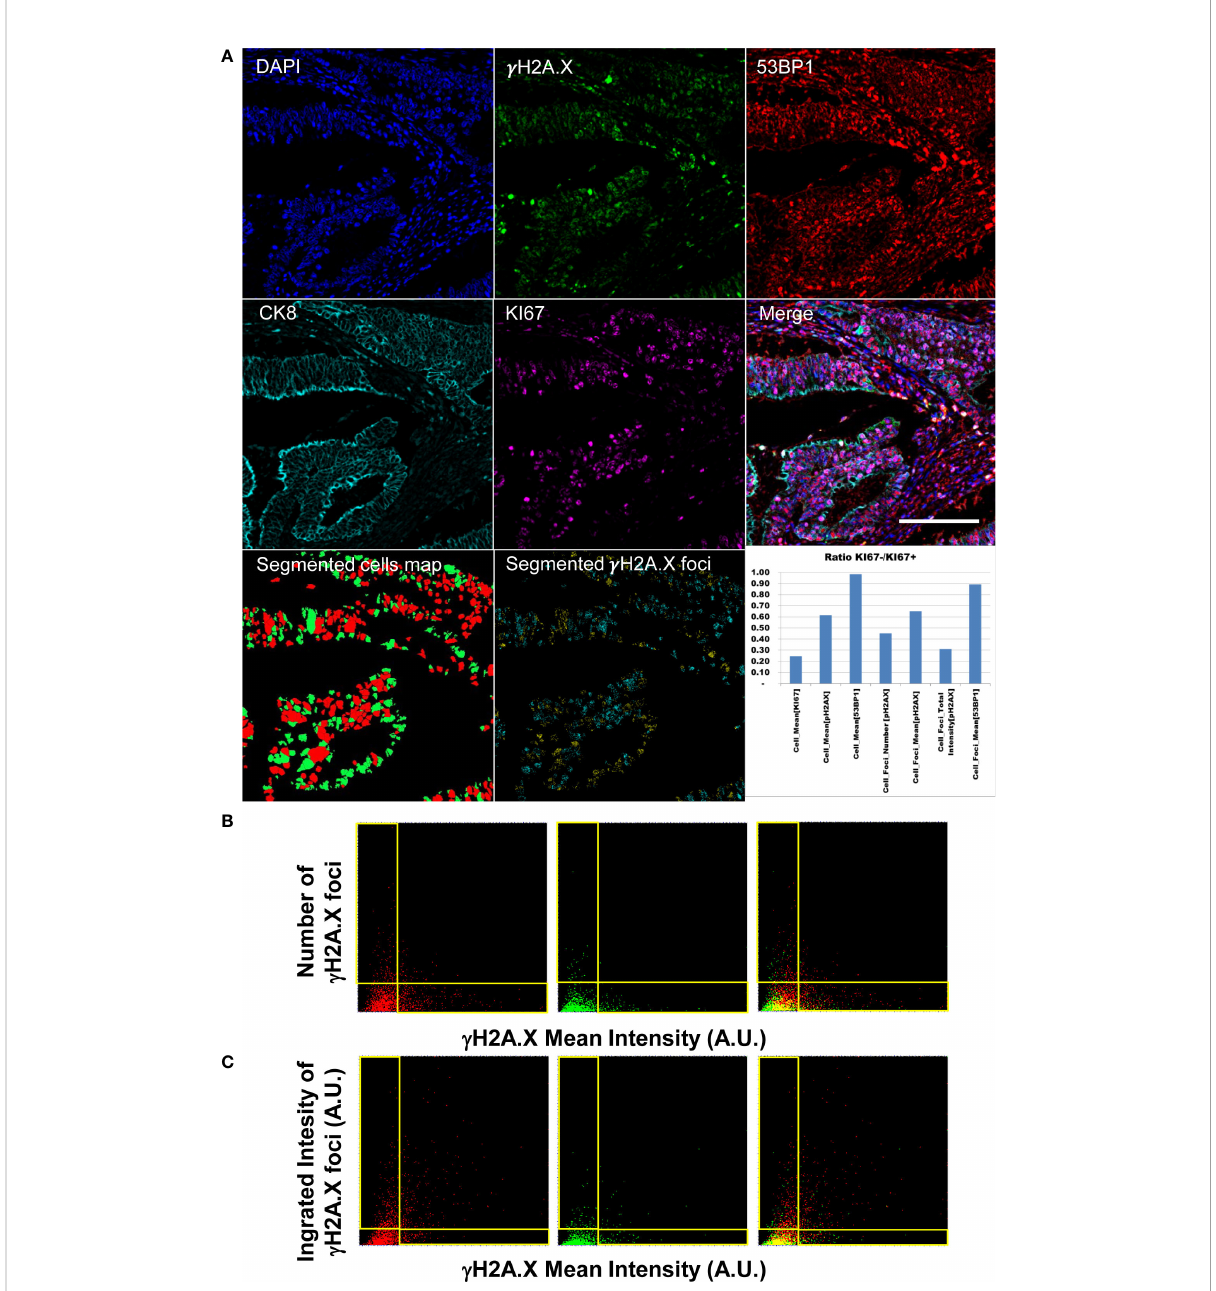
FIGURE 4 Diffraction-limited Image-Cytometry Analyis of a relocalized targeted core. Panel (A) : Images are collected with a 60x 1.4 Oil Immersion Objective to measure DDR related parameters at maximum spatial resolution and sensitivity on a selected region inside a previously acquired core: DAPI, g H2A.X, 53BP1, CK8 and KI67 (CK8 and KI67 rescaled to the same digital resolution from the previously acquired 20x acquisition employed to target the selected region; scale bar: 200 m m). Segmented masks of the cells (KI67+, Red; Ki67- Green) and of g H2A.X foci of the isolated cell populations (KI67+ Cyan spots; KI67- Yellow spots) are also reported. The graph shows the ratio of DDR related parameters values calculated for the quiescent and proliferant cell population. Panel (B) : Dot Plots reporting single-cell DDR related parameters. Mean Intensity (calculated as Mean Intensity value of the pixels contained in the segmented cell mask) of cell nuclei do not correlate with the number of detected foci per cell as demonstrated by the L-shaped distribution (events in the horizontal and vertical boxes) for the KI67+ (left), KI67- (middle) populations (right: merge). Panel (C) : Total Intensity of the detected foci (calculated as sum of the intensity value of the pixels contained in all the spot masks in a single cell) well summarizes the amount of DNA damage including both nuclear diffused and foci enriched cells in the KI67+ (left), KI67- (middle) populations (right: